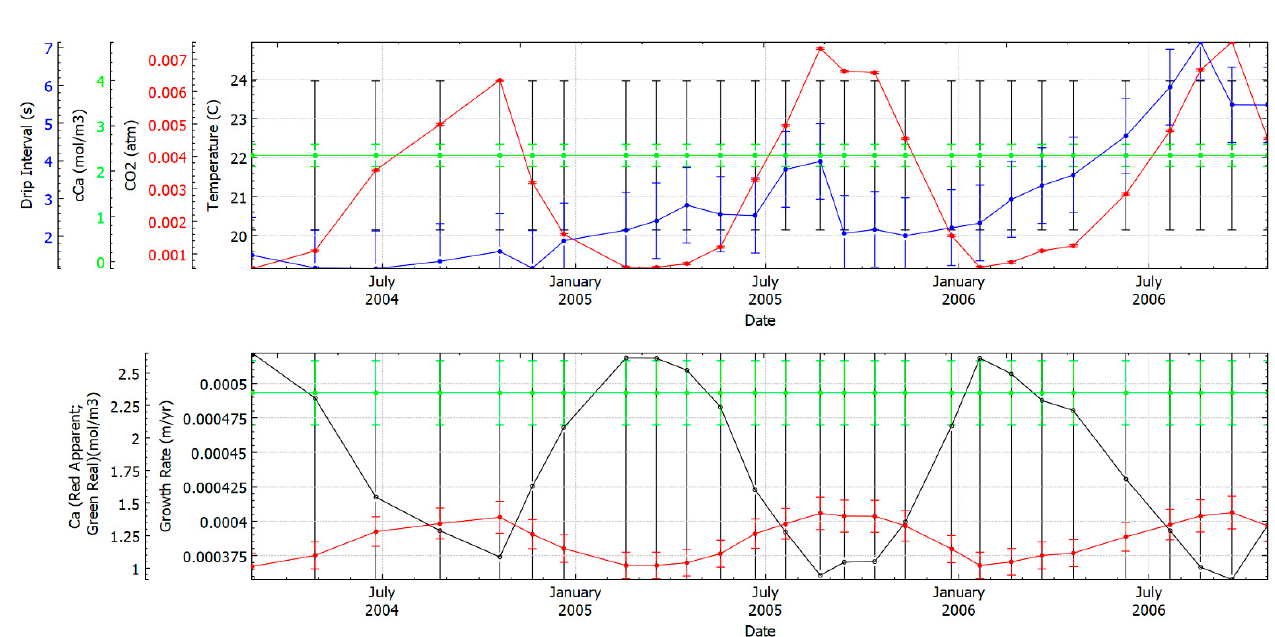
Figure 3. StalGrowth applied to Inner Space Cavern. The top plot shows the input parameters and the bottom plot shows the output of StalGrowth (see Figure 1 for more detail).